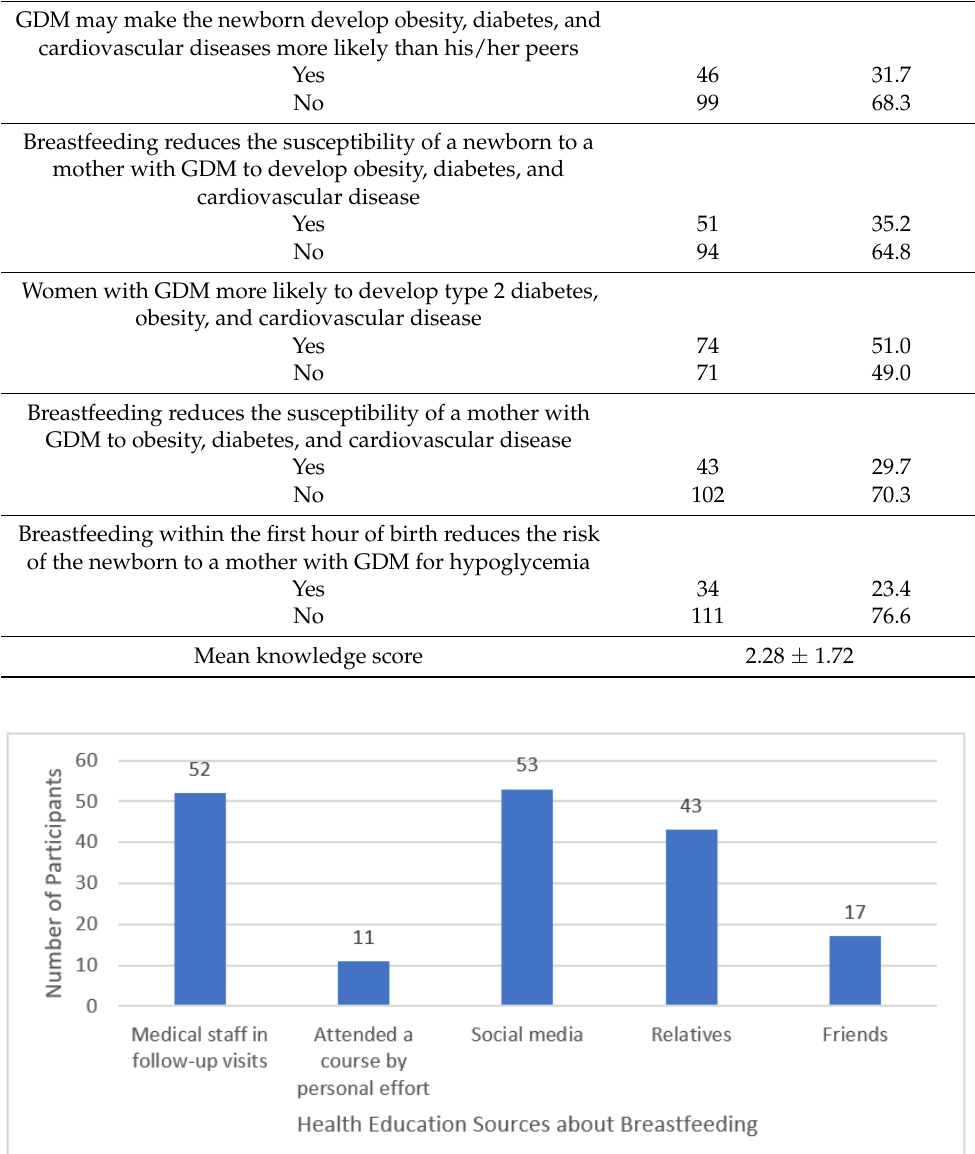
Table 4. Predictors of breastfeeding self-efficacy among expectant mothers with gestational diabetes mellitus (GDM) ( n = 145).